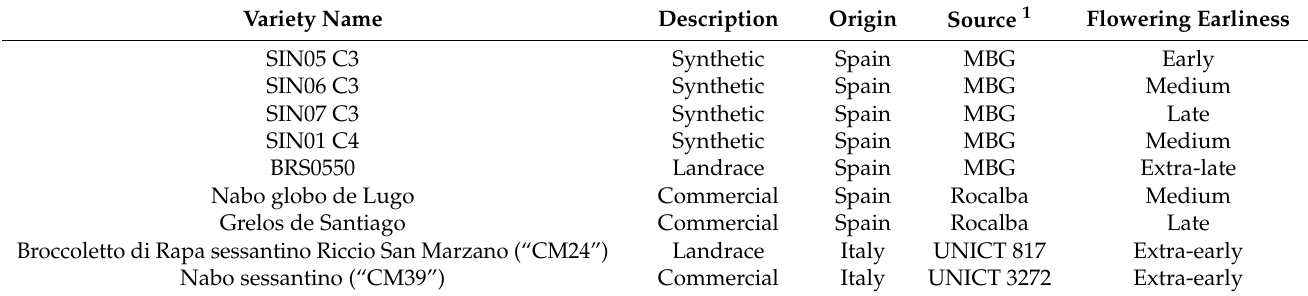
Table 1. Description of Brassica rapa varieties studied and their classification according to their flowering